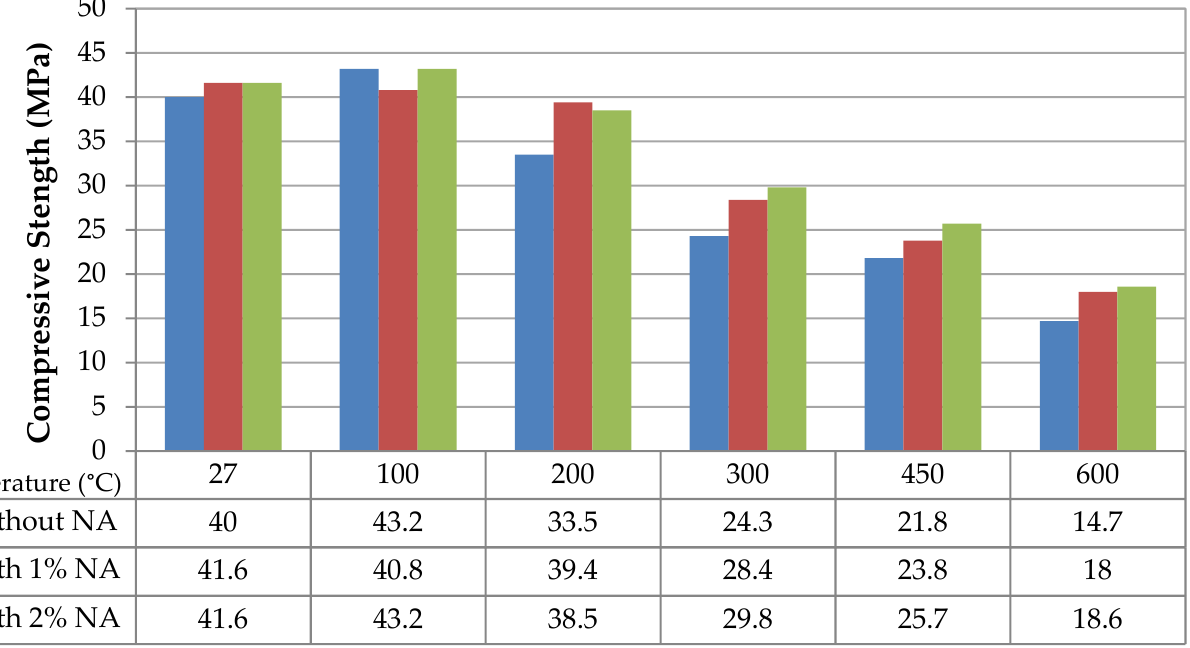
Figure 3. Comparison of 28-day compressive strength of self-compacting concrete (SCC) at target temperatures [27].